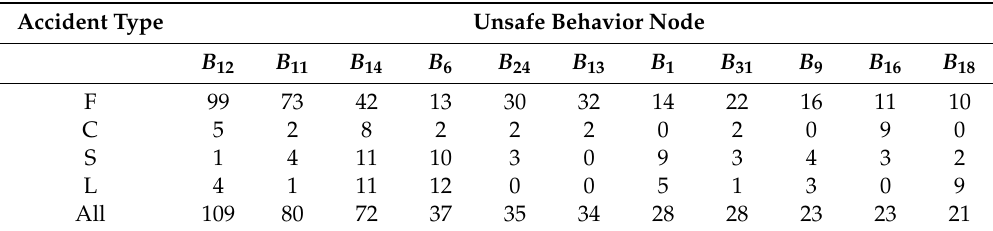
Table 3. The occurrences of several unsafe behaviors in the four types of accidents.